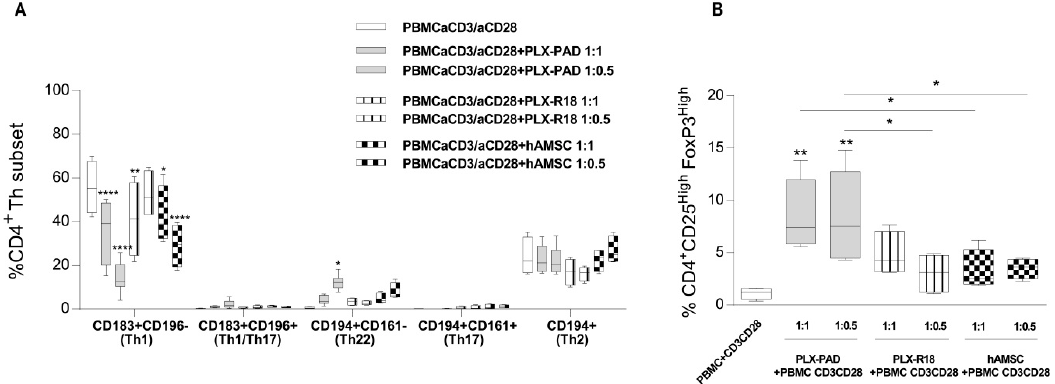
Figure 4. Effect of maternal and fetal derived MSC on Th1/Th2 and Treg polarization. Allogeneic PBMC were stimulated with anti-CD3/CD28 mAbs and co-cultured with MSC for six days. ( A ) Th1 (CD183 + CD196 − ), Th1/Th17 (CD183 + CD196 + ), Th22 (CD194 + CD161 − ), Th17 (CD194 + CD161 + ), and Th2 (CD194 + ) phenotypes were evaluated by flow cytometry at day 7 and expressed as a percentage of CD4 + CD45RA − gated cells. ( B ) Induction of Treg was evaluated by flow cytometry after six days of co-culture and it is displayed as a percentage of CD45RA − CD25 hi FoxP3 hi cells. Results are represented as mean±SEM (* p < 0.05, ** p < 0.01, **** p < 0.0001), n ≥ 4 individual experiments.